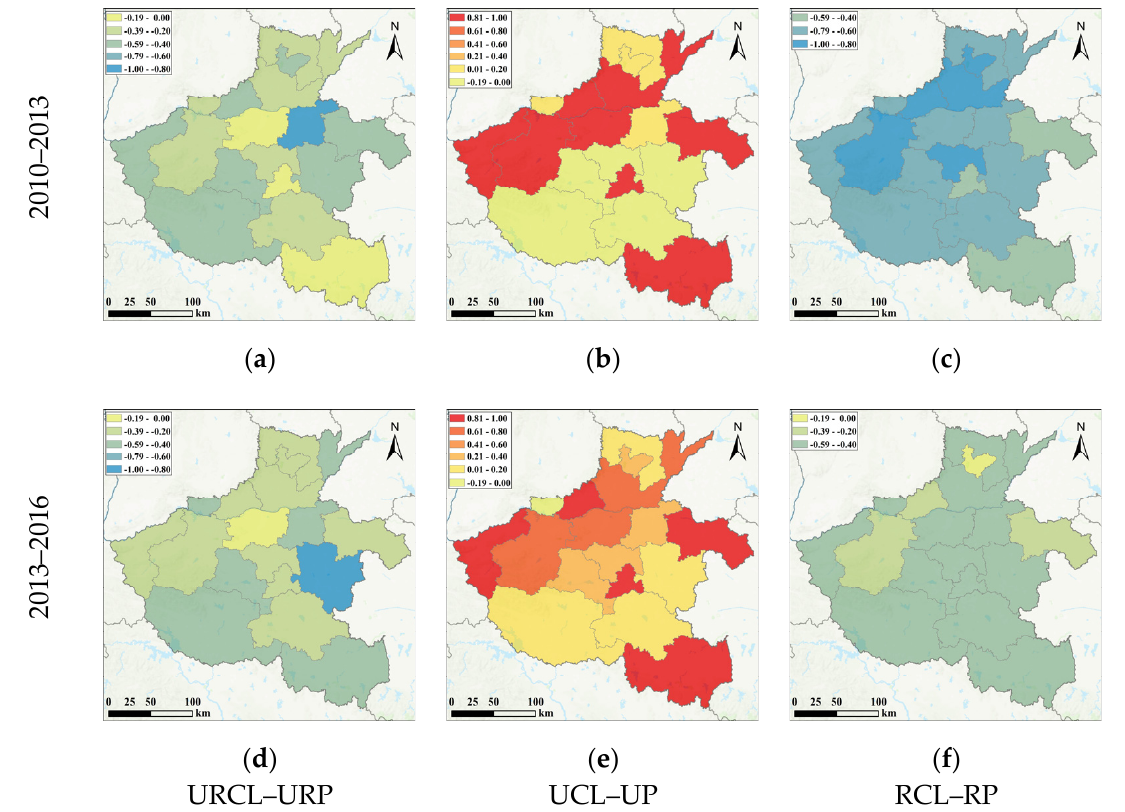
Figure 8. Regional changes of coupling rationality between URCL and population in Henan province from 2010 to 2016: ( a ) regional coupling rationality between URCL and URP from 2010 to 2013; ( b ) regional coupling rationality between UCL and UP from 2010 to 2013; ( c ) regional coupling rationality between RCL and RP from 2010 to 2013; ( d ) regional coupling rationality between URCL and URP from 2013 to 2016; ( e ) regional coupling rationality between UCL and UP from 2013 to 2016; ( f ) regional coupling rationality between RCL and RP from 2013 to 2016.